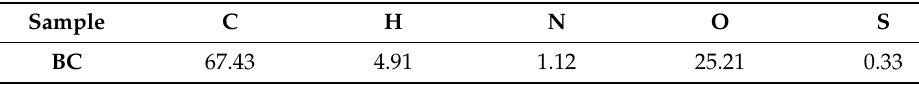
Table 1. Elemental composition (%) of biochar (BC).